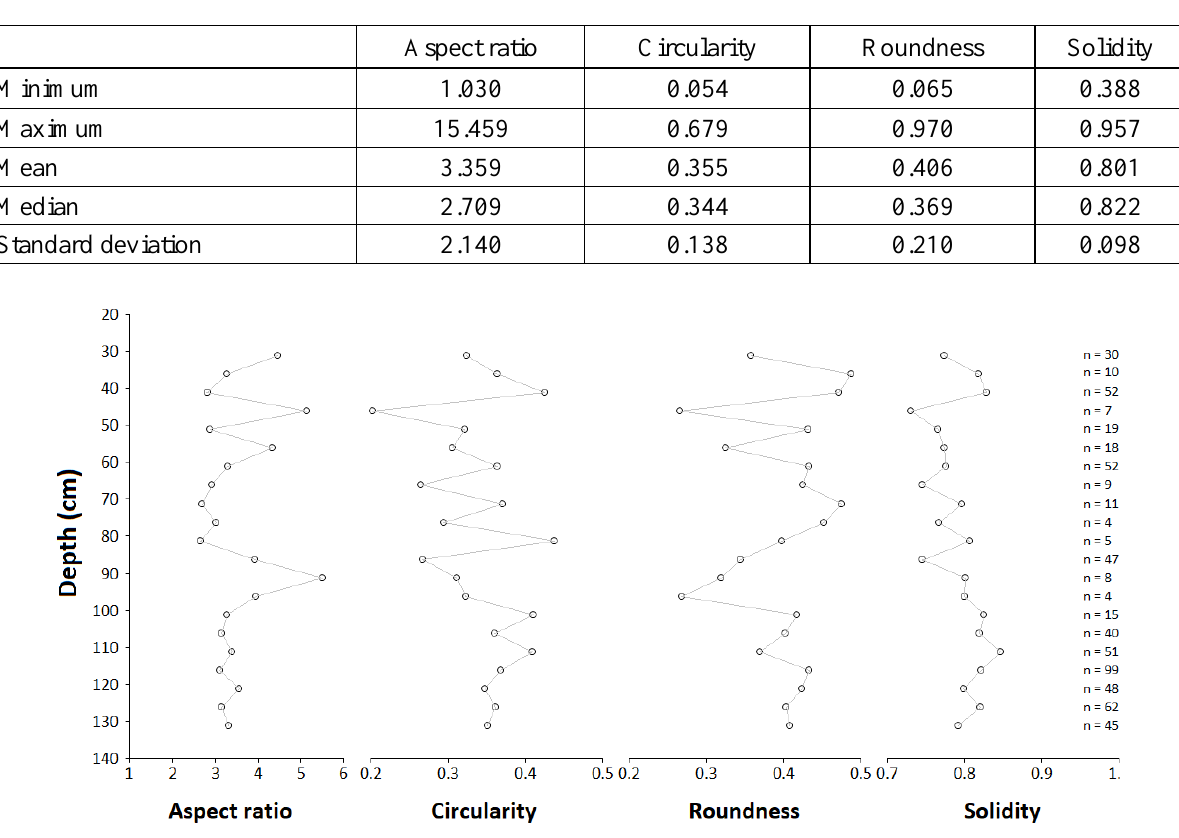
Figure 4. Variation of mean shape descriptors with